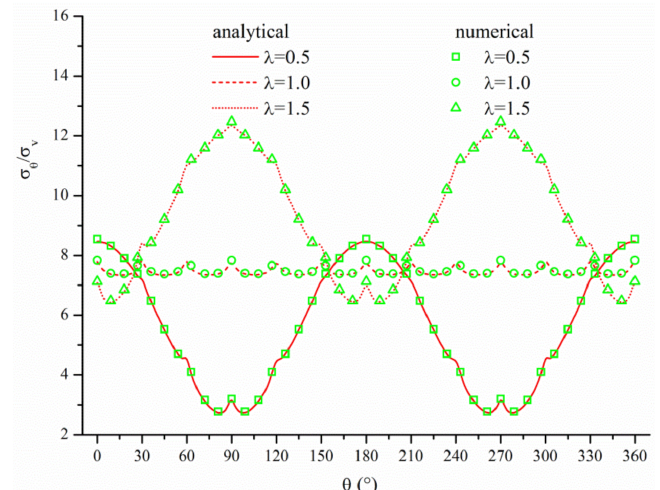
Figure 4. A comparison of axial forces of the bolts.